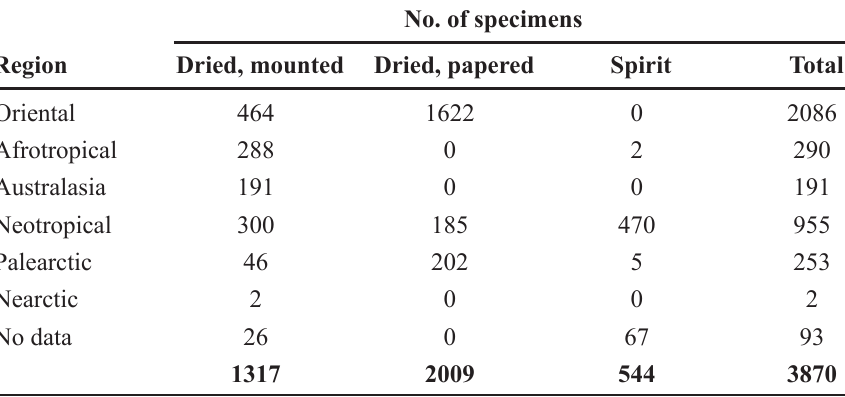
Table 2. Number of undetermined Dermaptera specimens in the Manchester Museum by geographical